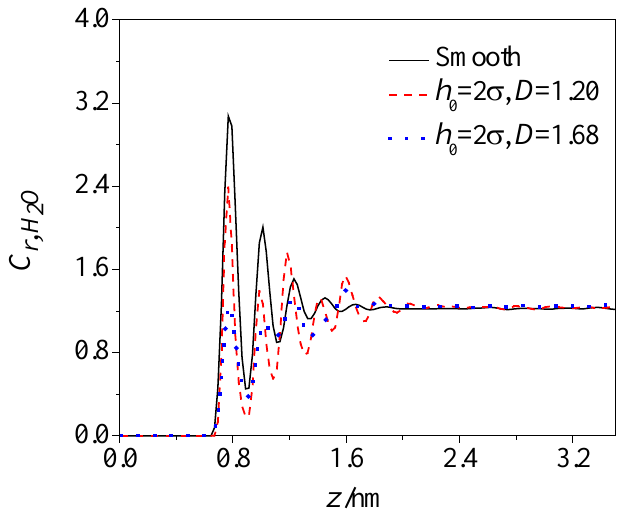
Figure 4. Effect of fractal dimension on concentration distribution of water molecules.